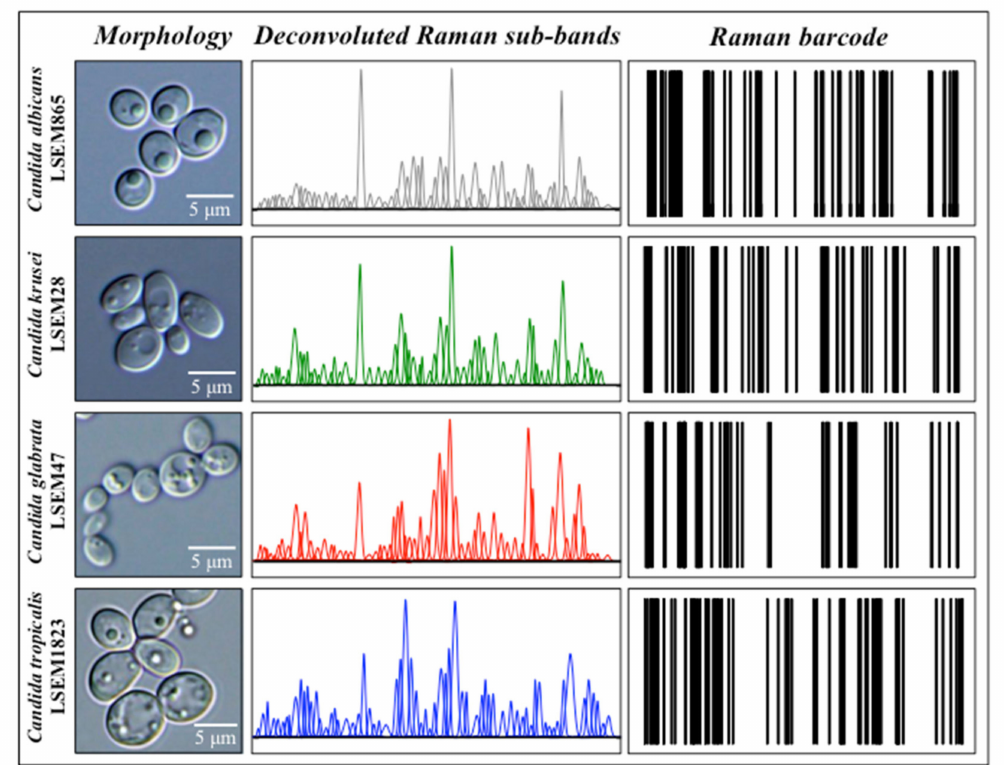
Figure 11. High-resolution DIC micrographs, series of deconvoluted Raman sub-bands for the four studied Candida species, and their conversion into Raman barcodes according to the algorithm described in Section 4.5 (cf. labels in